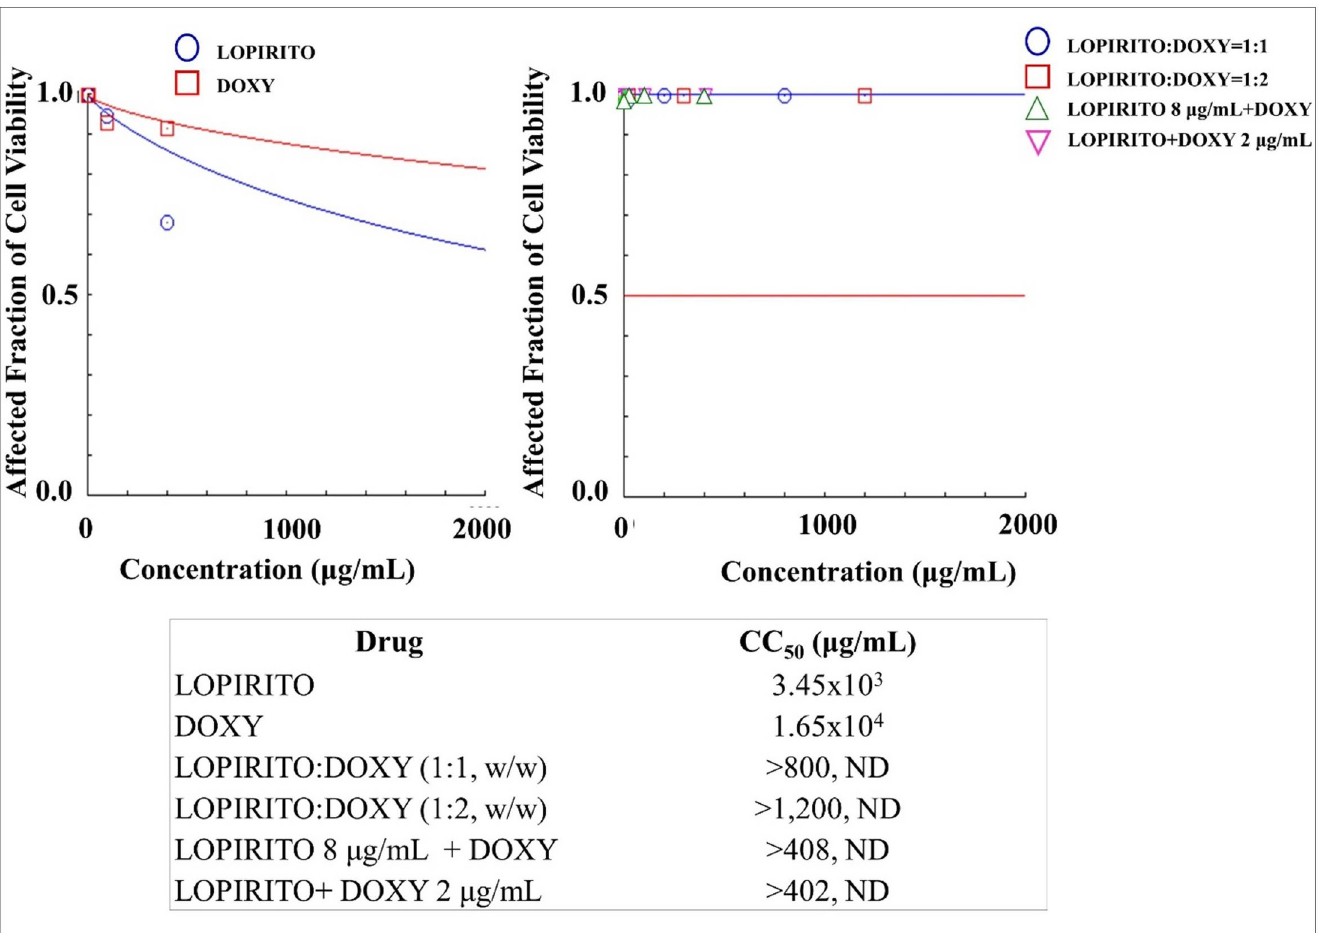
Fig 6. The cytotoxicities of Lopinavir-Ritonavir (LOPIRITO) and Doxycycline (DOXY) as a single drug (left) and dual drug combination in constant and non- constant ratios (right) analysed by using CompuSyn Software (n = 3). At non-constant ratios of LOPIRITO 8 μ g/mL + DOXY, LOPIRITO was added at a concentration of 8 μ g/mL to each increased levels of DOXY i.e. 0.2, 2, 10, 100, and 400 μ g/mL. On the other hand, DOXY was then added at a concentration of 2 μ g/mL to each increased levels of LOPIRITO i.e. 0.2, 2, 10, 100, and 400 μ g/mL to produce LOPIRITO + DOXY 2 μ g/mL.